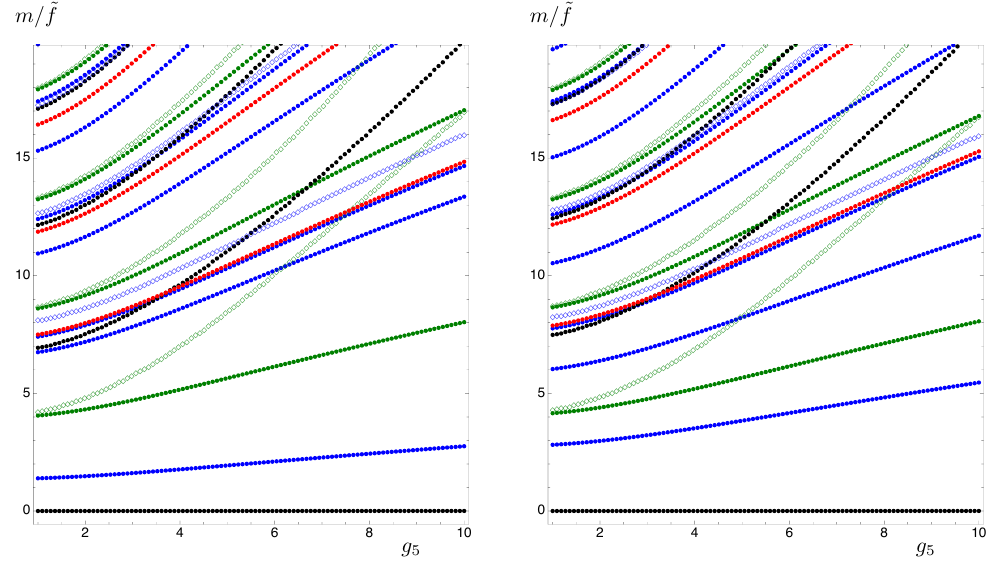
Figure 13 . Model IIA (left) and IIB (right). Spectrum as a function of g 5 for x F = 1 , ∆ = 3 , ∆ = 1 , ρ = − 13 , ρ = 8 , and φ = 2 (Model IIA, left), φ φ 1 2 A √ to the decay constant ˜ f ≡ f/ N C . The colour coding for the spectrum is: singlet scalar (blue), non-singlet scalar (blue diamonds), tensor (red), pseudoscalar (black), vector (green), axial-vector (green